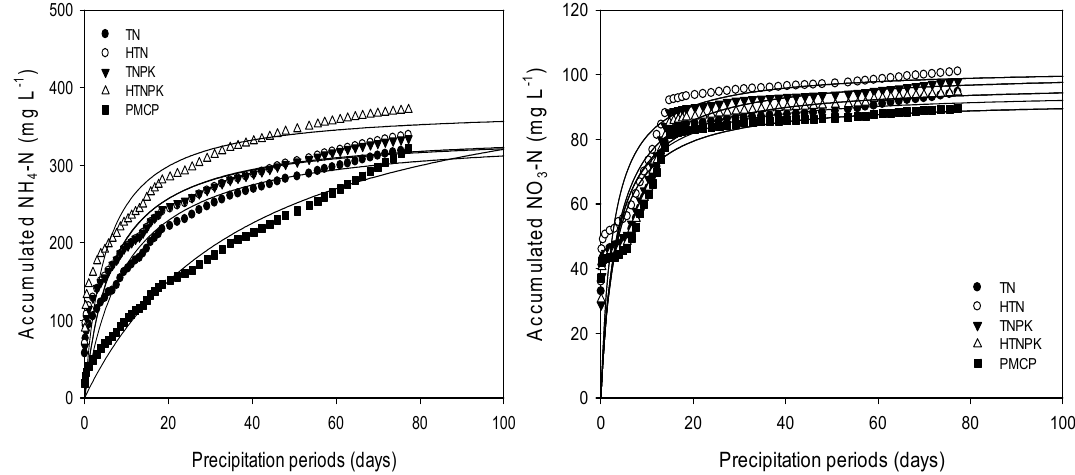
Figure 1. Releasing curves of NH 4 -N and NO 3 -N from different blended biochar pellets uploaded with plant nutrient solutions. The results are the mean of triplicate samples. Error bars indicate the standard deviation.